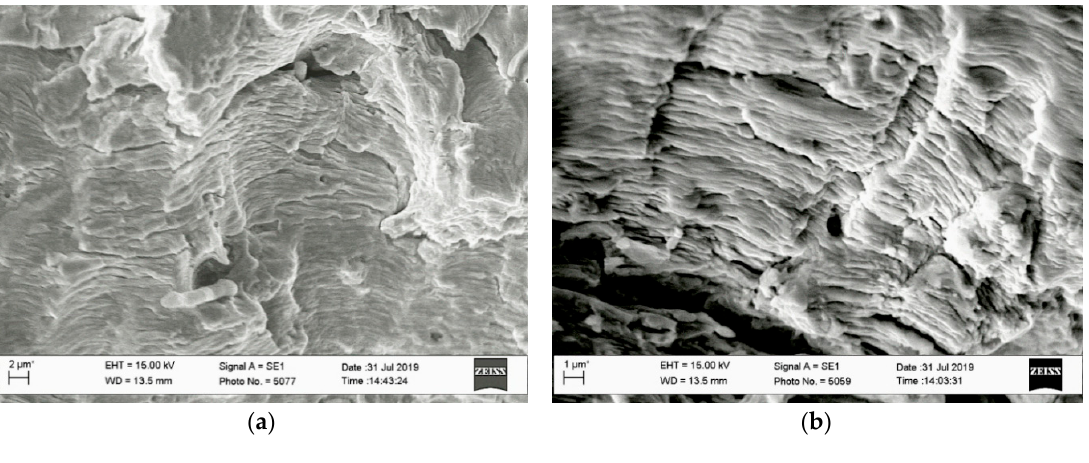
Figure 14. Typical illustrations of the fatigue-fracture surfaces of a specimen tested at a minimum amplitude of K III type (30 degrees): ( a ) Traces of contact between the conjugated surfaces in the load cycle; ( b ) fatigue striations at the final stage within starting zone of the crack growth (at the crack length near 2 mm) in the middle of the specimen